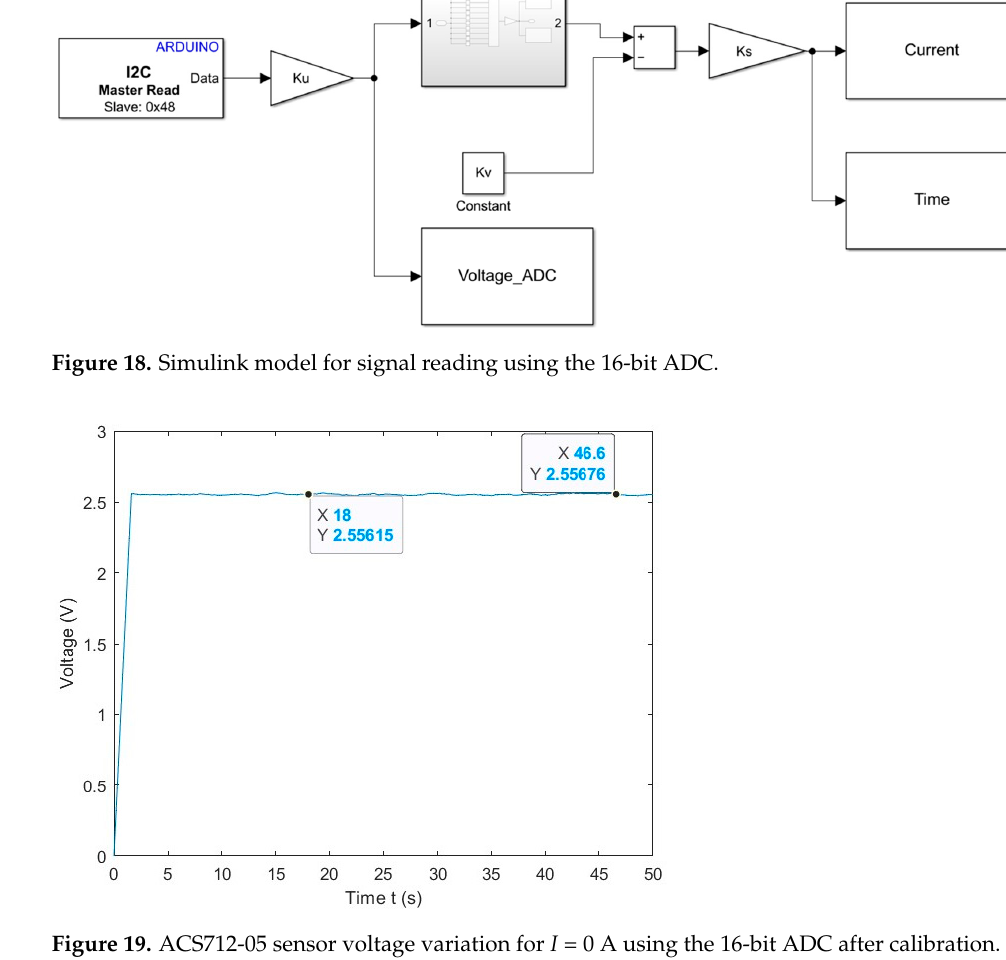
Figure 19. ACS712-05 sensor voltage variation for I = 0 A using the 16-bit ADC after calibration.